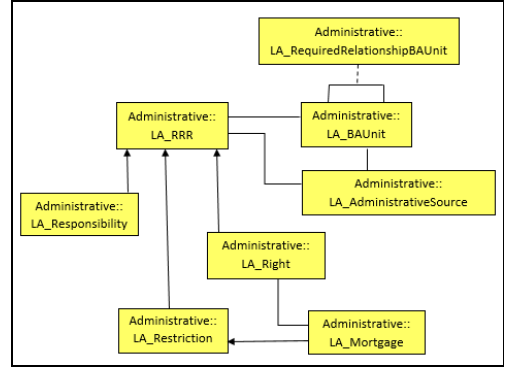
Figure 4. LADM Administrative and Classes Package